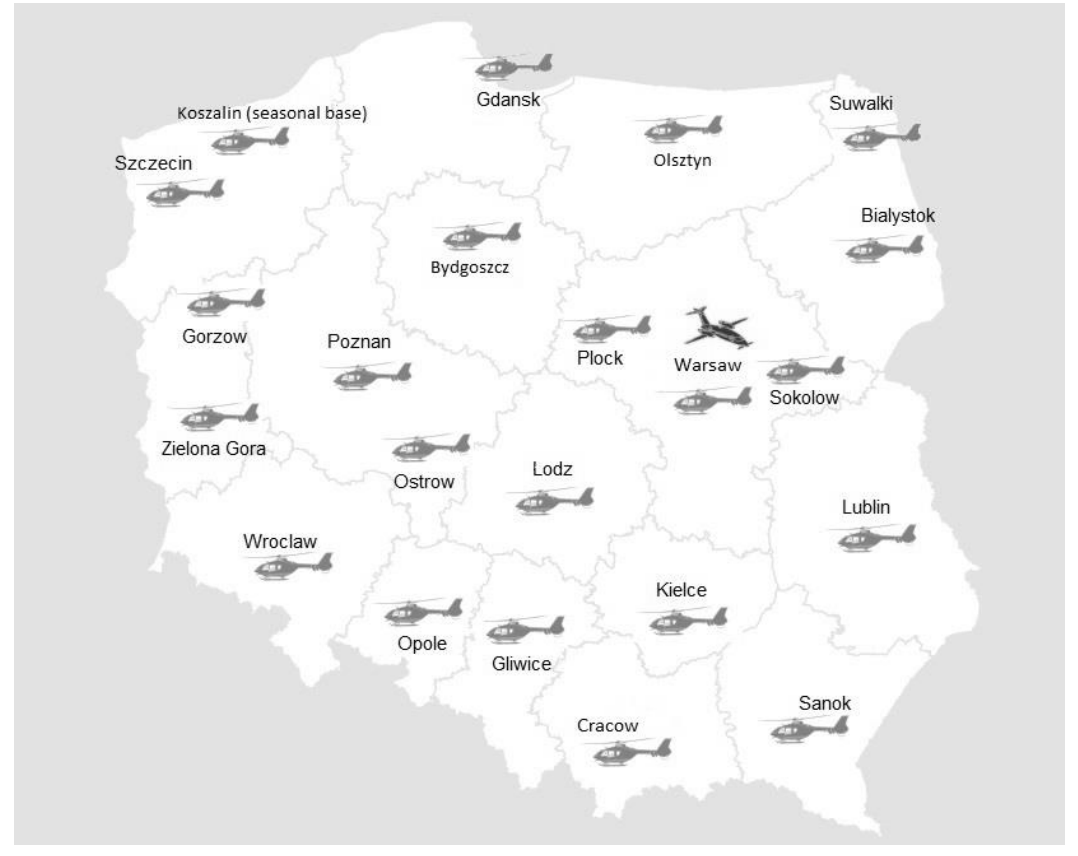
Figure 1. Location of Emergency Medical Service (EMS) and Helicopter Emergency Medical Service (HEMS) bases in Poland.